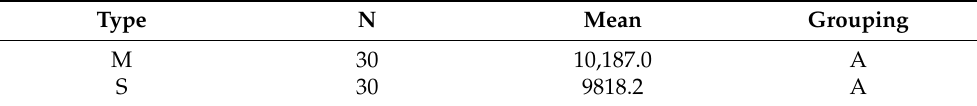
Table 12. Tukey Pairwise Comparisons on